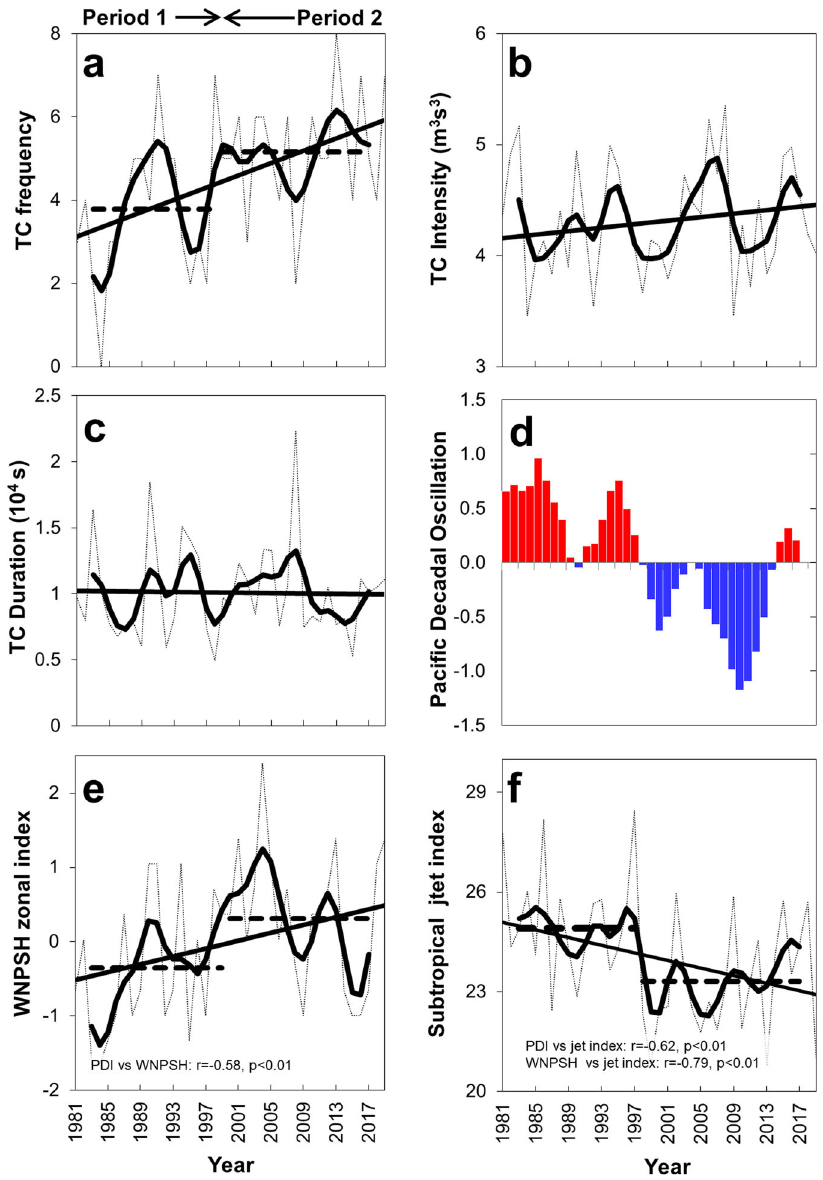
Fig. 3 Components of the Power Dissipation Index (PDI) in East Asia (EA) during the mature boreal autumn. a − c Timeseries of the indicated components of PDI in EA. d Timeseries of the 5-year running centered mean of the Paci fi c Decadal Oscillation (PDO). e , f Timeseries of the Western North Paci fi c subtropical high zonal index and East Asian subtropical jet index, respectively. In a − c , e , f , the thick (thin) line represents the timeseries of the 1-3-4-3-1 fi ltered (raw) timeseries, respectively. In a , e , f , the black dashed lines indicate the abrupt regime shift in PDI during the Period 1 (1981 − 1997) and Period 2 (1998 − 2019), respectively. Signi fi cance is tested using student ’ s t-test statistic with two- tailed